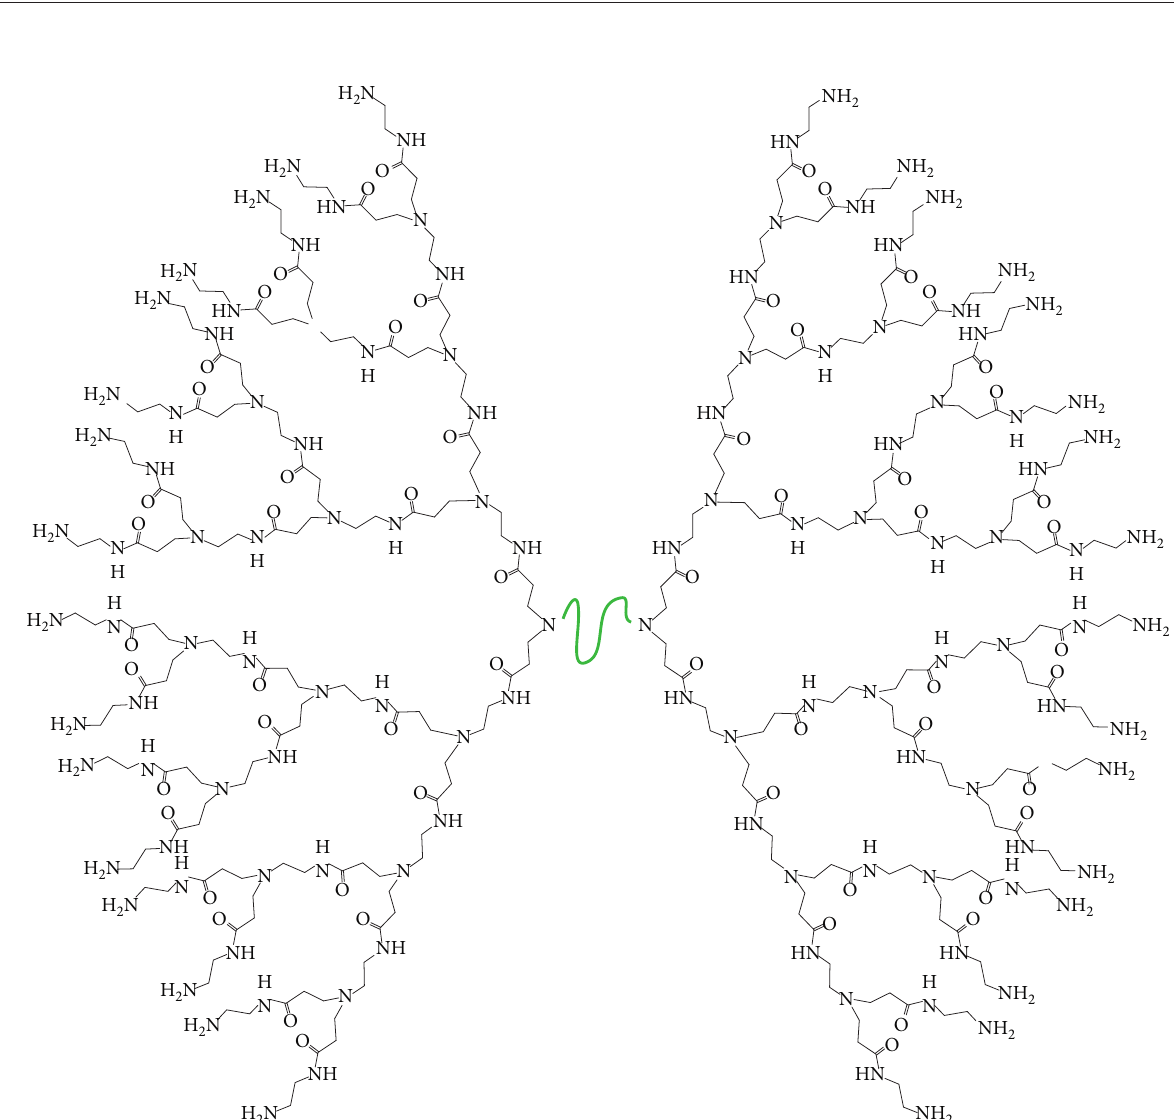
Figure 1: The structure of PEG-cored PAMAM dendrimer